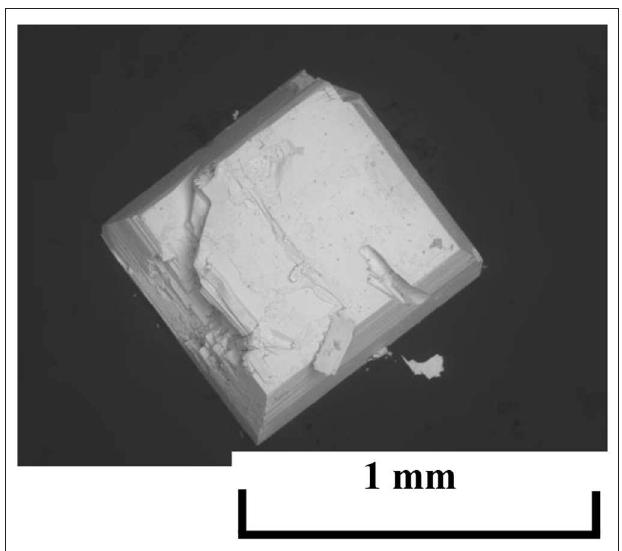
FIGURE 1 | Typical SEM image of (Ce,Pr)OBiS 2 single crystal.